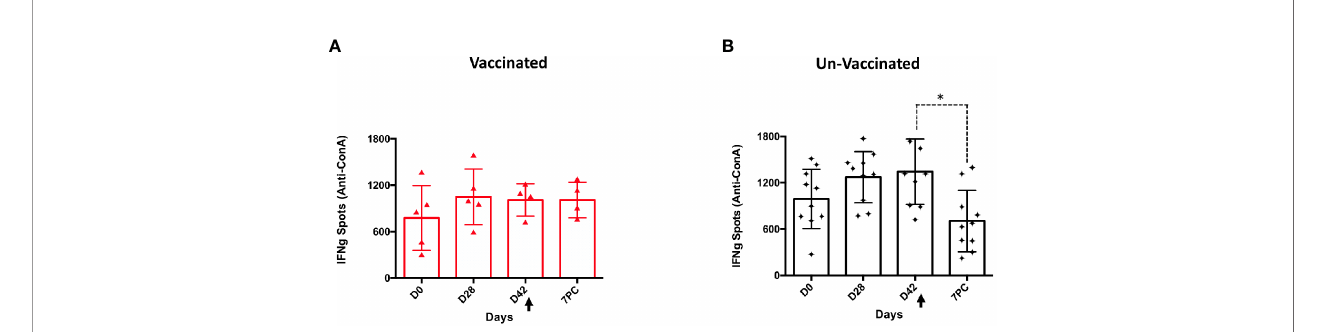
FIGURE 7 | Immunosuppression in PPRV-infected sheep. T cells responding to Con-A stimulation producing IFN- g at days 0, 28, and 42 post-vaccination and day 7 after challenge in BoHV-4-A-PPRV-H- D TK-vaccinated sheep (A) and control sheep (PBS and BoHV-4-A- D TK) (B) . Each dot corresponds to the average IFN- g spot count for 10 6 cells in one animal. Bars indicate the average of all animals. A Wilcoxon matched-pairs signed-rank test was used for statistical analysis (* p < 0.05). The black arrow (D42) denotes the time of virulent PPRV ICV ’ 89 challenge in all animals.